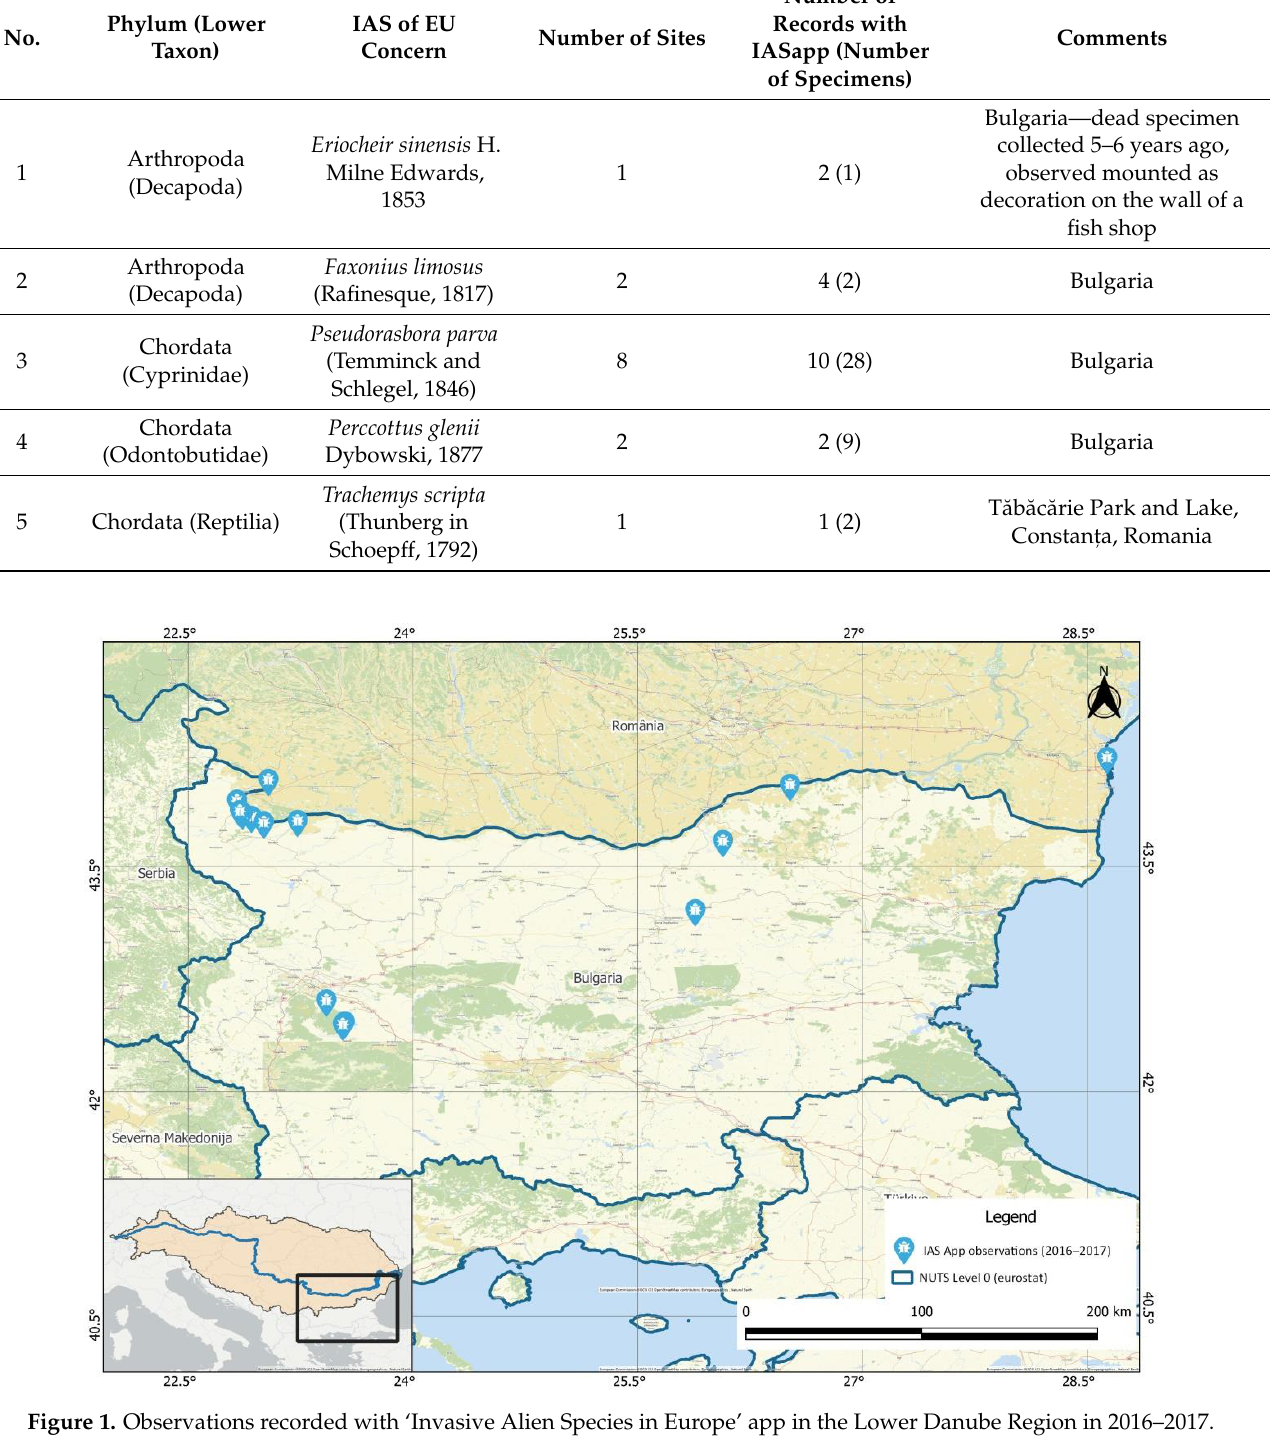
Figure 1. Observations recorded with ‘Invasive Alien Species in Europe’ app in the Lower Danube Region in 2016–2017.